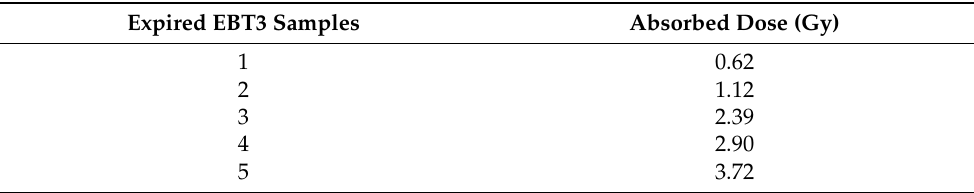
Table 1. Absorbed dose at each film samples for 90 kVp X-ray energy.